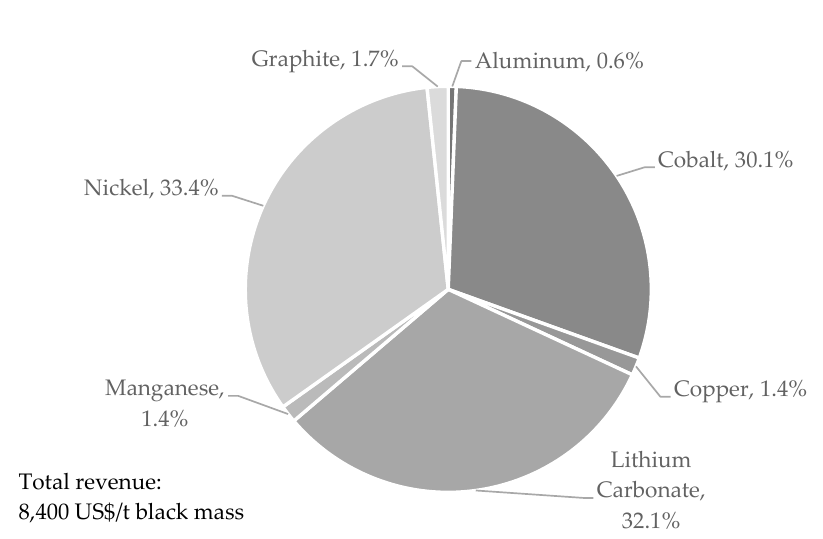
Figure 11. Theoretical revenue distribution of black mass with NMC 622.